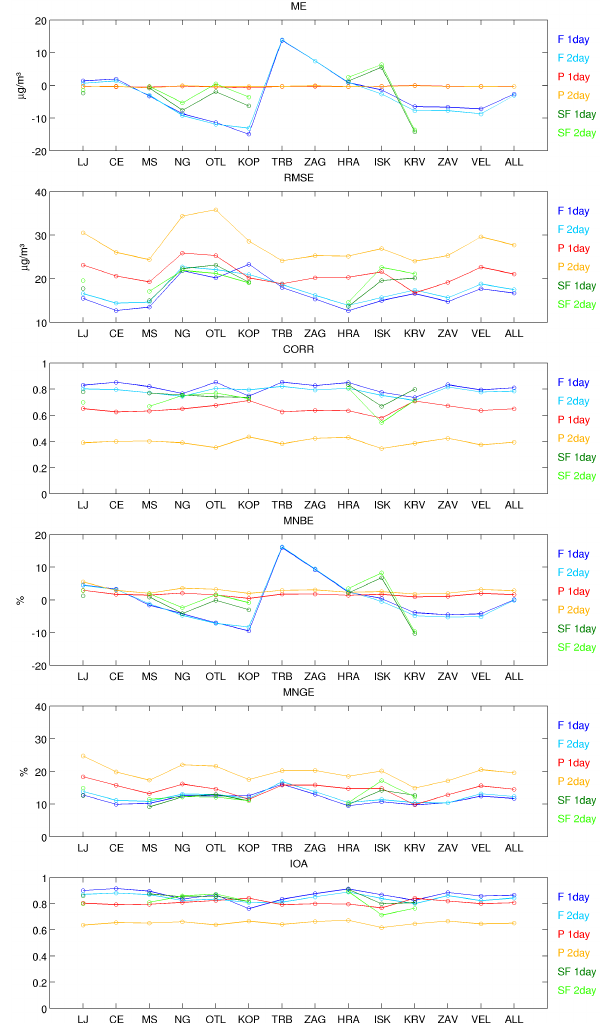
Figure 8. Site-by-site comparison of discrete statistics for 1-day and 2-day WRF-Chem (F 1 day, F 2 day), statistical (SF 1 day, SF 2 day) and persistence model (P 1 day, P 2 day) predictions of ozone daily maxima during the 3 summer months analysed.